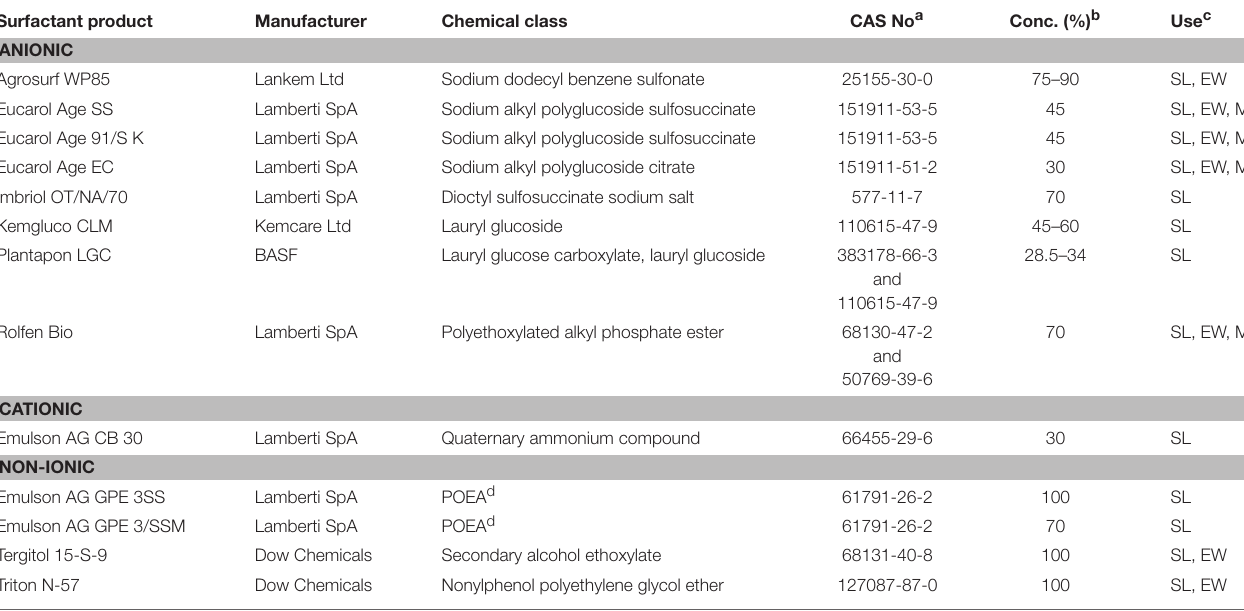
TABLE 1 | Various types of surfactants used in pesticide formulations. Surfactant